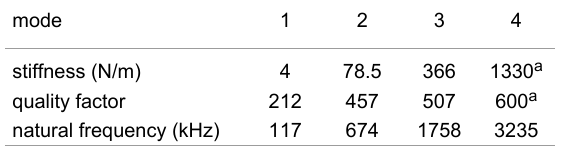
Table 1: Calibrated cantilever parameters for the